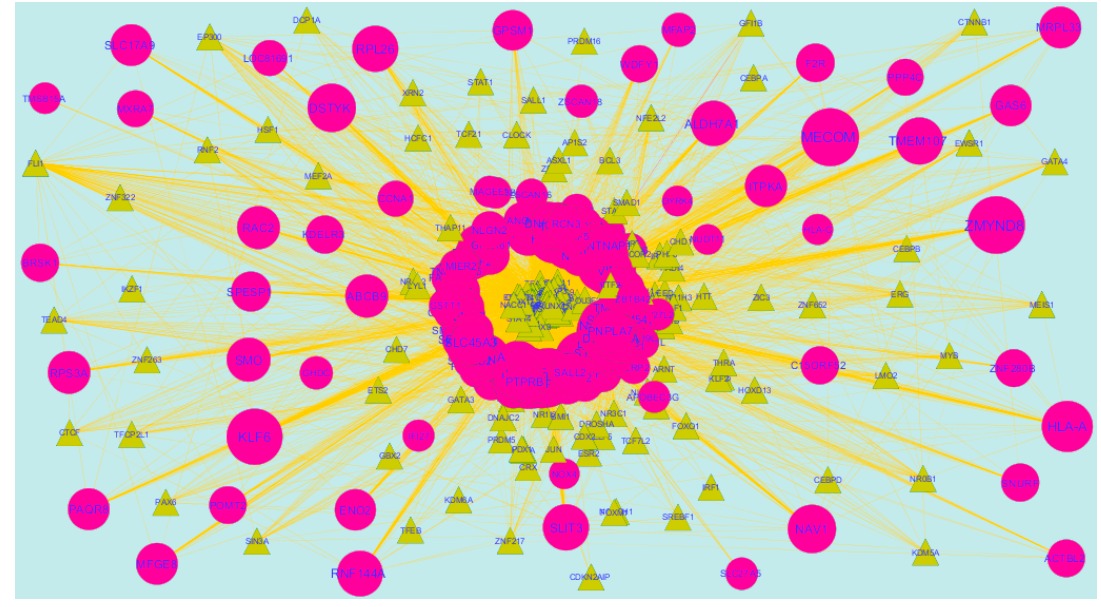
Figure 15. TF- gene network of predicted target down-regulated genes. Yellow triangles are TFs and pink circles are target down-regulated genes. Yellow lines means interaction with adjutant genes or TFs.